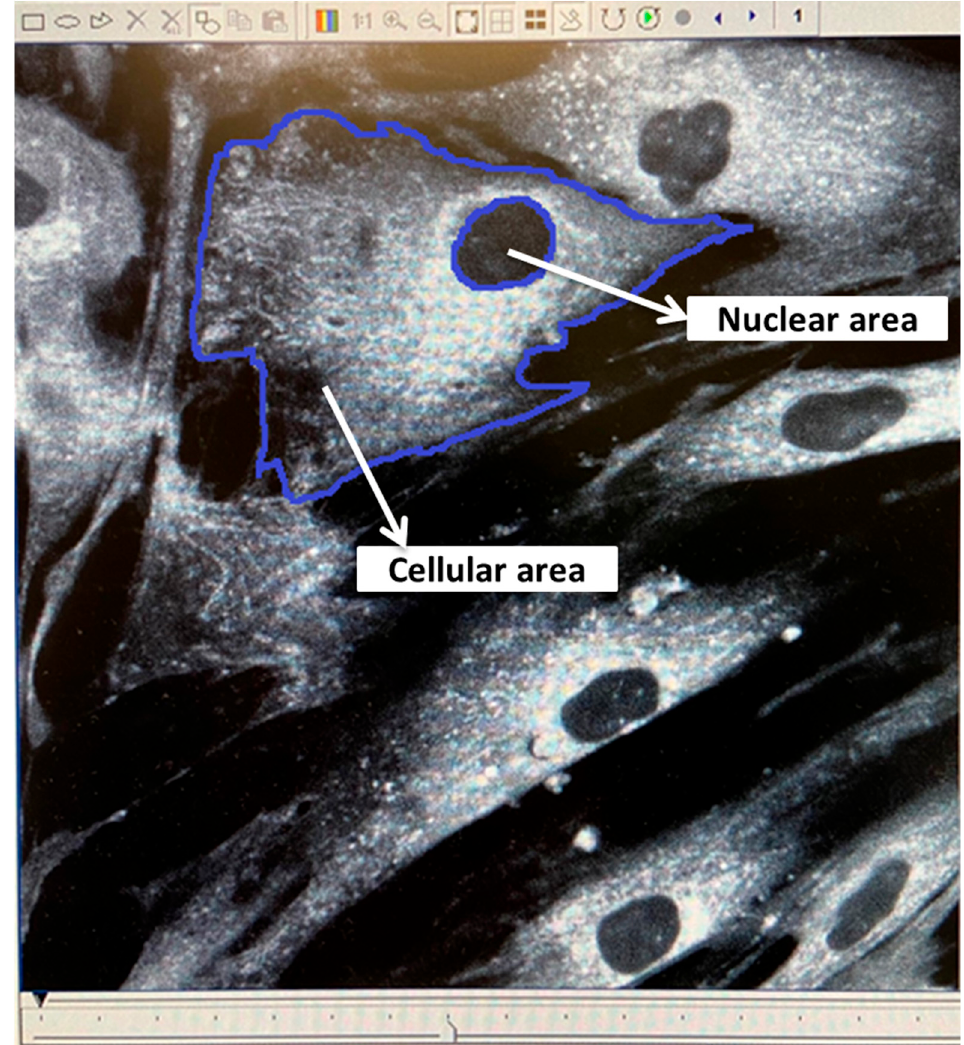
Figure 1. Confocal images of living HF19 cells stained with DIOC6. The image was taken by a confocal laser scanning microscope using a ×60 oil lens. The dimension of the resulting image is 196 µm × 196 µm.